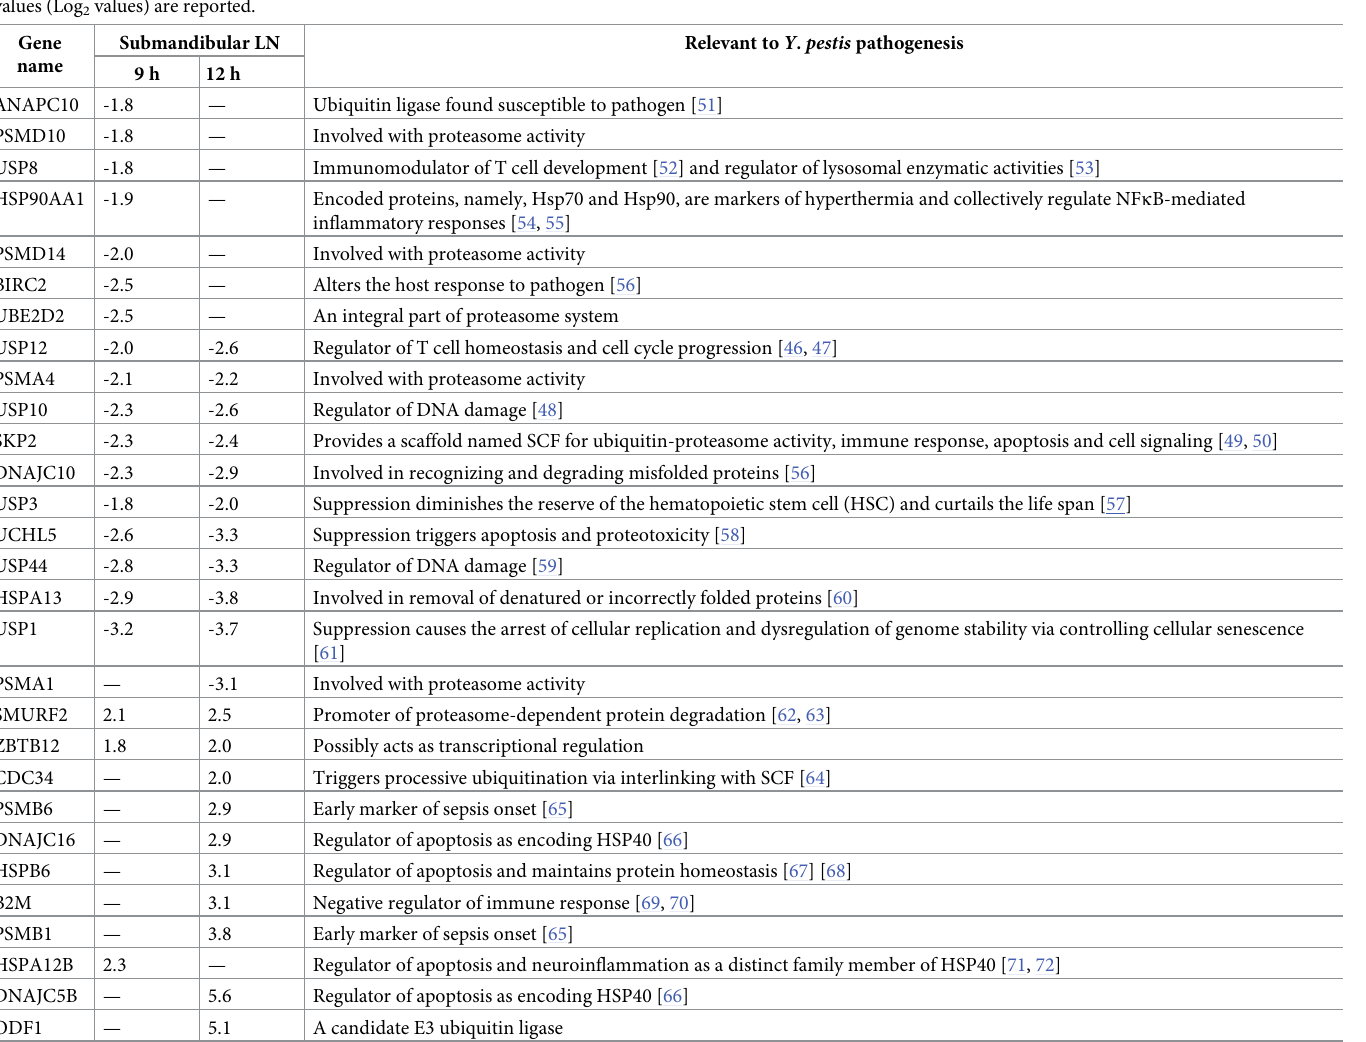
Table 3. Genes of interest from the ubiquitin network. Genes showing early response for at least two early time points (9 h and 12 h p.i) are listed. Only the significant values (Log 2 values) are